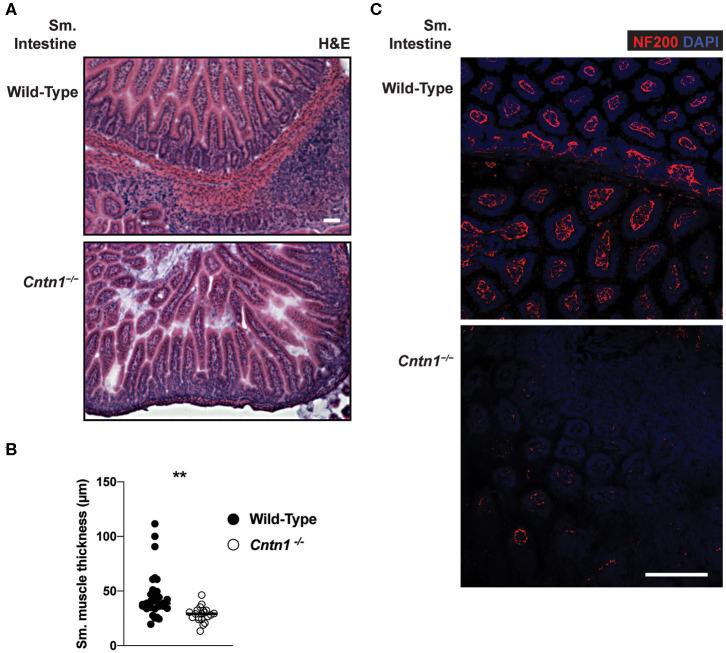
Altered neuromuscular homeostasis in Cntn1-/- small intestine (A) Representative images of P11 small intestine from wild-type (top) and Cntn1−/− (bottom) at 10 × (H&E). White scale bars represent 50 μm (B). Graph shows measurements of smooth muscle thickness in histology sections. From wild-type and Cntn1−/− animals. Analysis of aggregated data by Student's t-test (C) Representative immunofluorescence images of small intestine from wild-type (top) and Cntn1−/− (bottom) costained for NF200 (red) and DAPI (blue) White scale bar represents 50 μm. **p < 0.01.